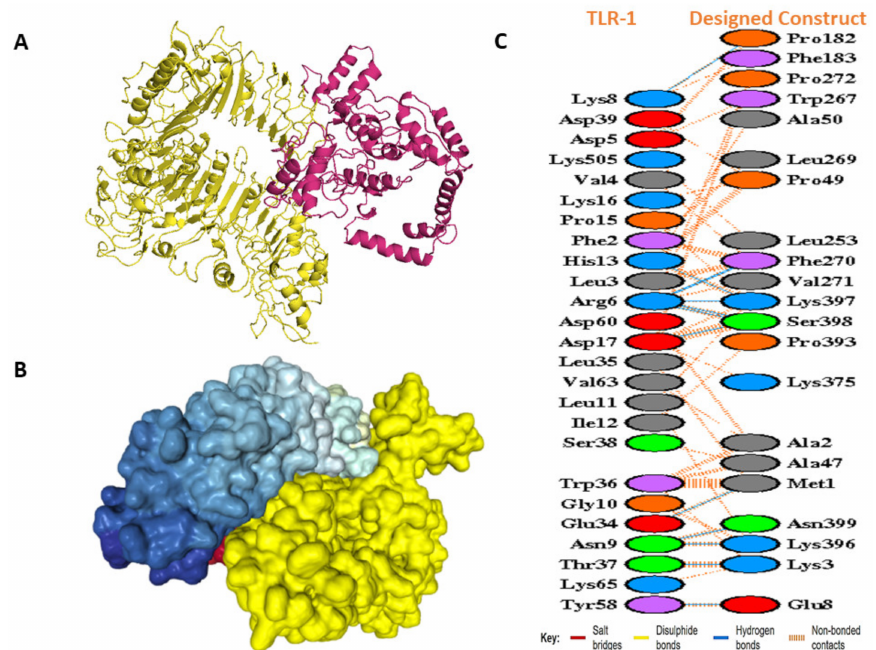
Figure 7. Docking studies of the designed construct with TLR 1. ( A ) Docked complex as generated by the ClusPro webserver. The yellow ribbon structure reflects the TLR1 molecule, while the warm pink represents the vaccine molecule. ( B ) Vaccine’s docked complex generated by HDOCK (yellow represents vaccine). ( C ) Residue interactions between TLR 1 and the vaccine construct. Hydrogen bonds are specified with blue color lines.